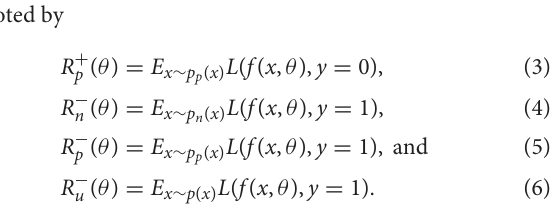
as either tumor or non-tumor. A straightforward solution would and labeling all the voxels in patches coming from S 0 with label